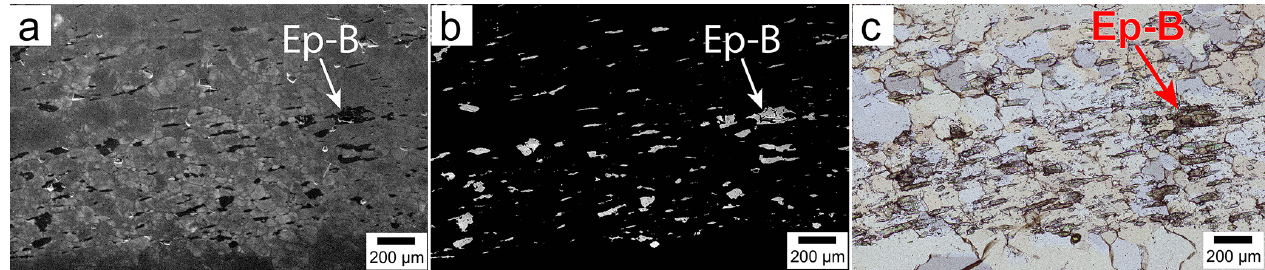
Figure 12. Cathodoluminescence (CL; a ) and backscattered electron images (b) of the microstructural domain in the transmitted-light microphotograph of panel (c) . The only minerals in the images are epidote (Epidote-B; Ep-B) and quartz (unlabeled grains). The different CL contrasts in quartz (a) are due to variable trace element contents. The anomalous birefringence in panel (c) is due to the thickness of the thin section (ca. 60µm).